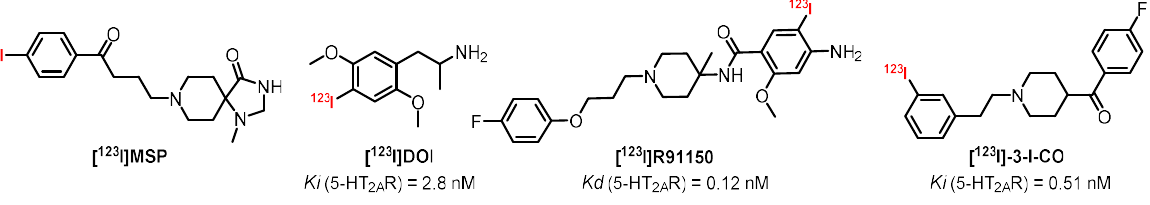
2A R SPECT imaging